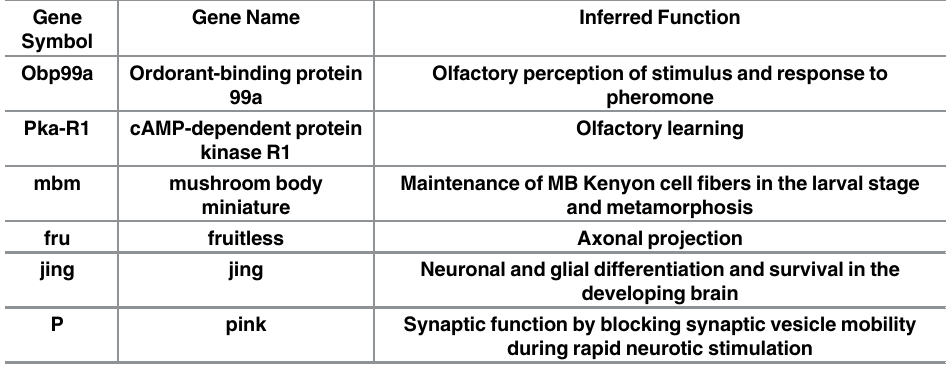
List of selected cognitive linked genes and their functions that are identi fi ed in Microarray analysis and validated in adult head tissue using quantitative